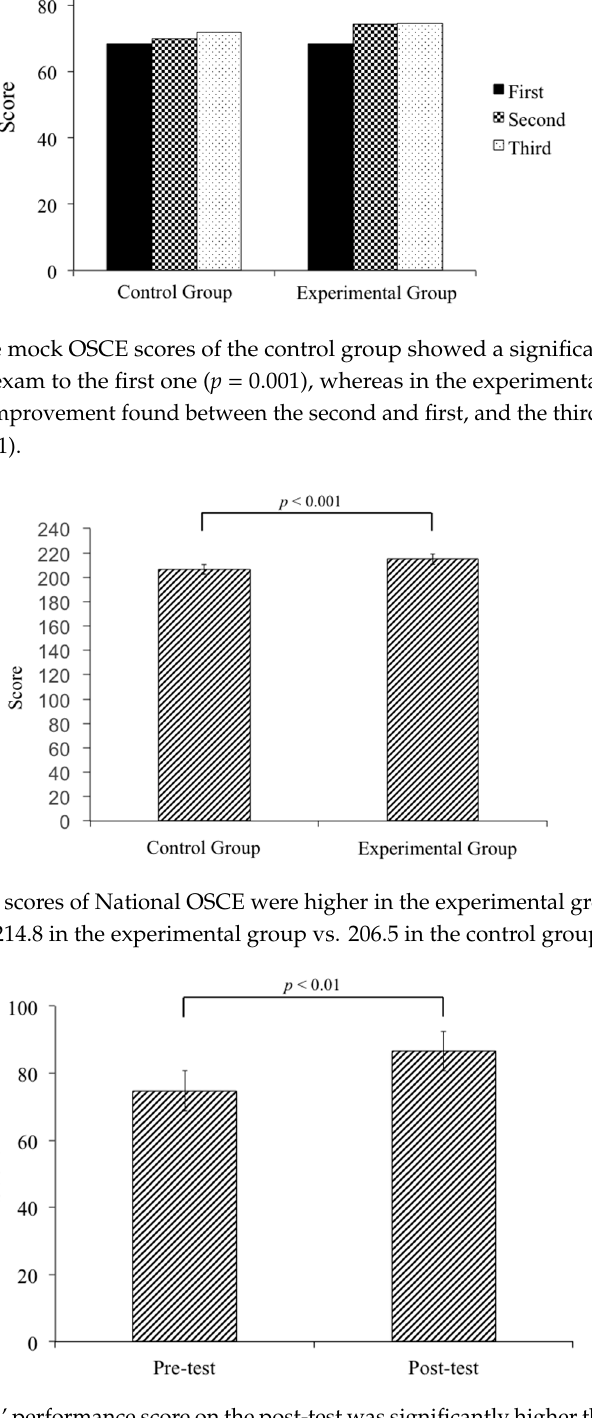
Figure 6. The students’ performance score on the post-test was significantly higher than the pretest (74.8 ± 9.87 for pretest vs. 86.6 ± 11.49 for posttest, p < 0.001) in the experimental group. Student’s t-test was used in comparison between pre-test and post-test. A p -value < 0.05 is considered statistically significant.